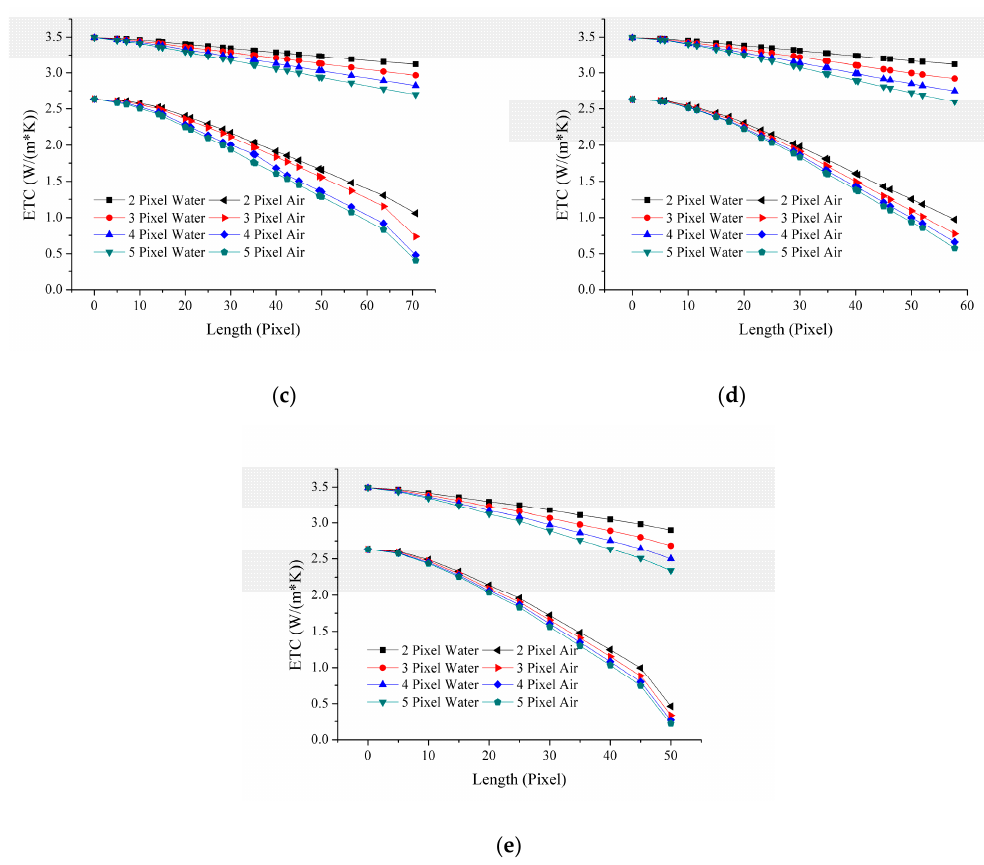
Figure 7. Effective thermal conductivity as a function of fracture length and aperture. The angles between thermal conduction and the fracture were ( a ) 0°, ( b ) 30°, ( c ) 45°, ( d ) 60°, and ( e ) 90°.